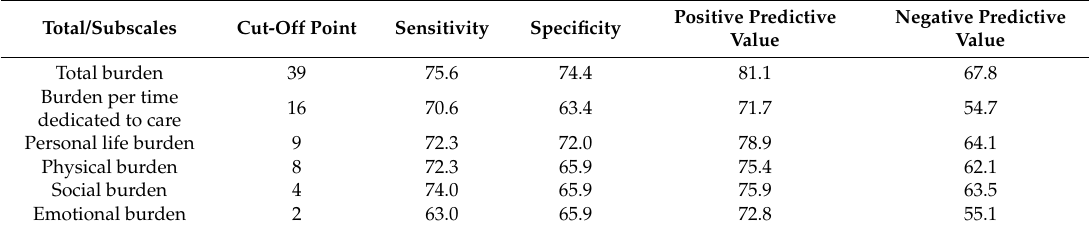
Table 3. Discriminant analysis and percentage of cases correctly classified of the original CBI.